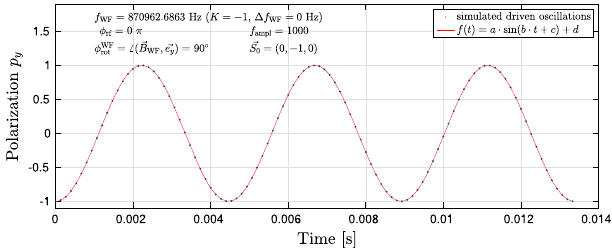
⃗ S 2 ð t Þ ⃗ ¼ 0 S 0 ¼ − ⃗ e , ϕ y rf